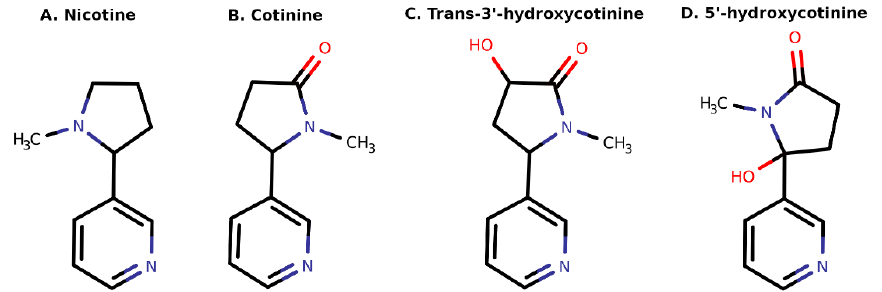
Figure 1. Two-dimensional sketches of nicotine and its three important metabolites. Heteroatoms oxygen (O) and nitrogen (N) with valanced hydrogens are colored red and blue, respectively. oxygen (O) and nitrogen (N) with valanced hydrogens are colored red and blue,